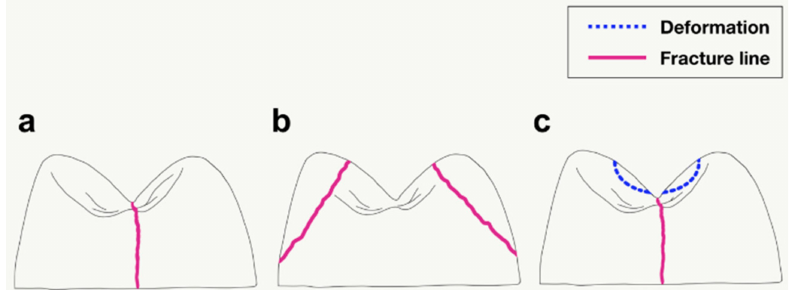
Figure 6. Three aspects of fracture after indirect tensile fracture test (sagittal view). ( a ) Fracture occurred in the middle of the tooth. ( b ) Tooth fragments fell off from both cusps near loading point. ( c ) After depression due to metal round bar, a center crack began and spread downwards.